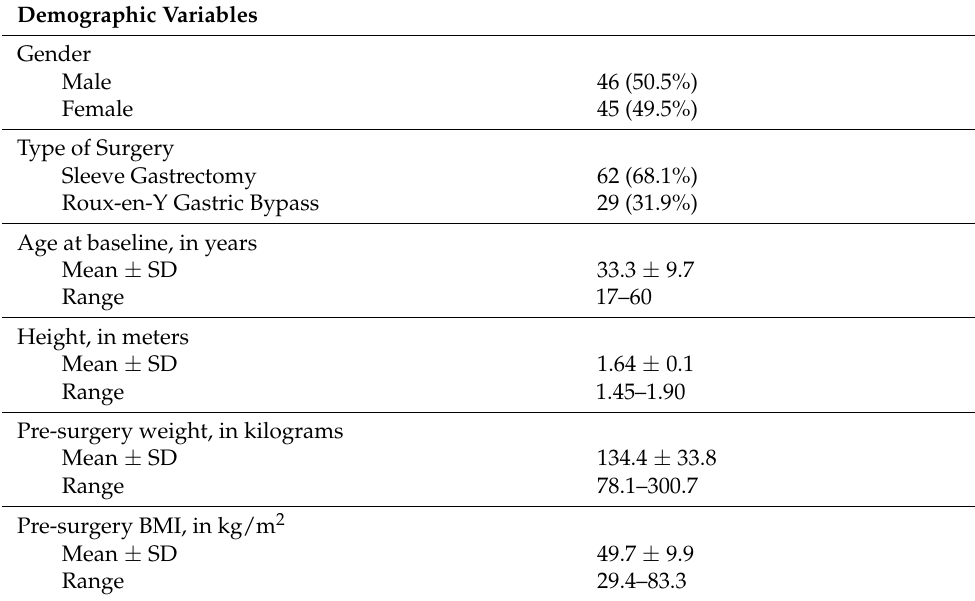
Table 1. Overall demographic data and baseline characteristics of patients with obesity who under- went bariatric surgery. The values are represented as mean ± SD (standard